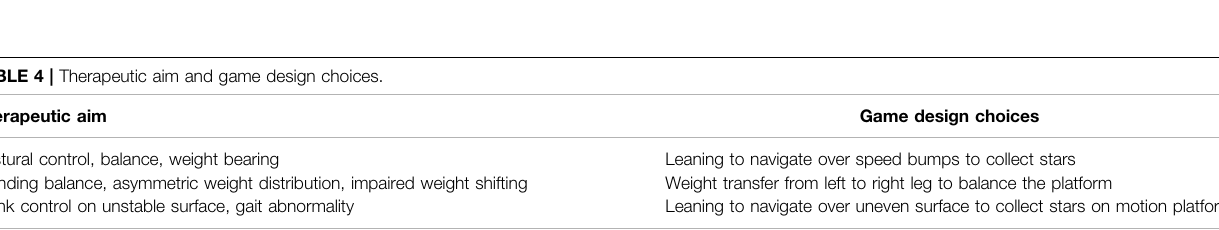
FIGURE 3 | The information flow between the different components within the system and the controller containing the haptic model.